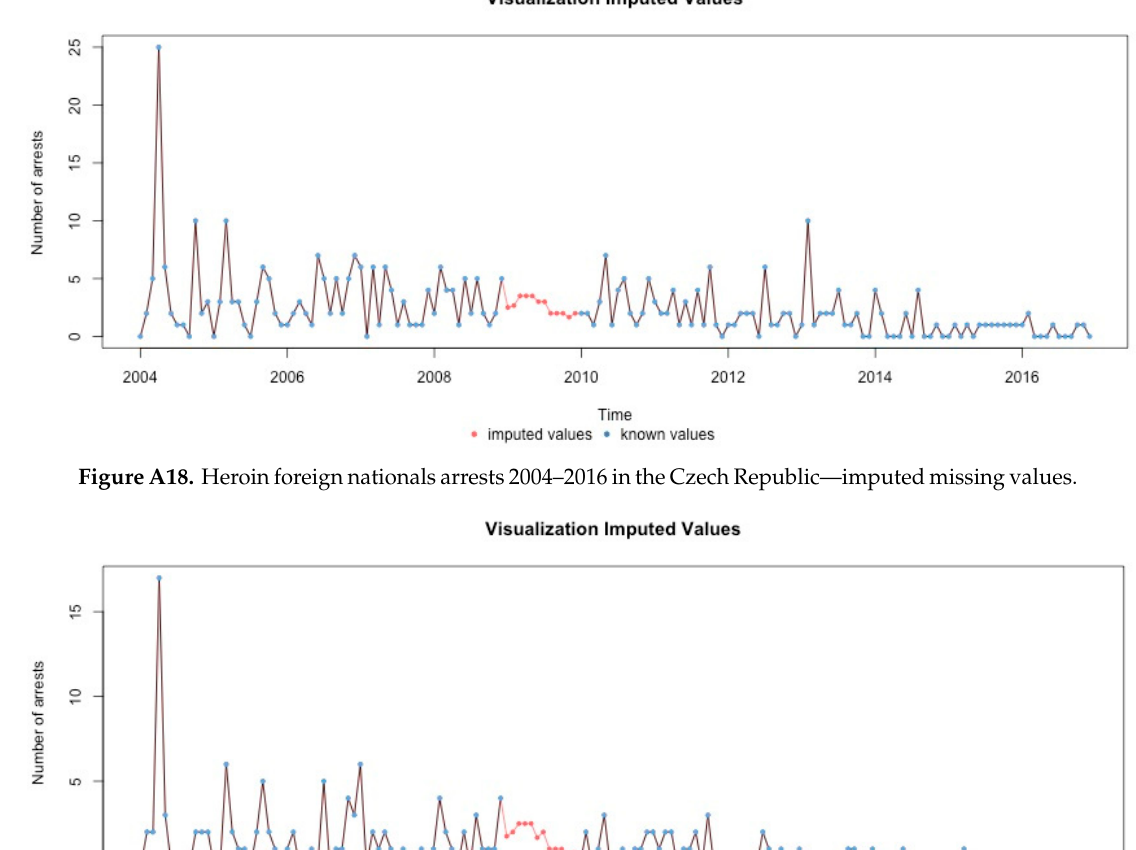
Figure A17. Heroin Czech nationals arrests 2004–2016 in the Czech Republic – imputed missing values.